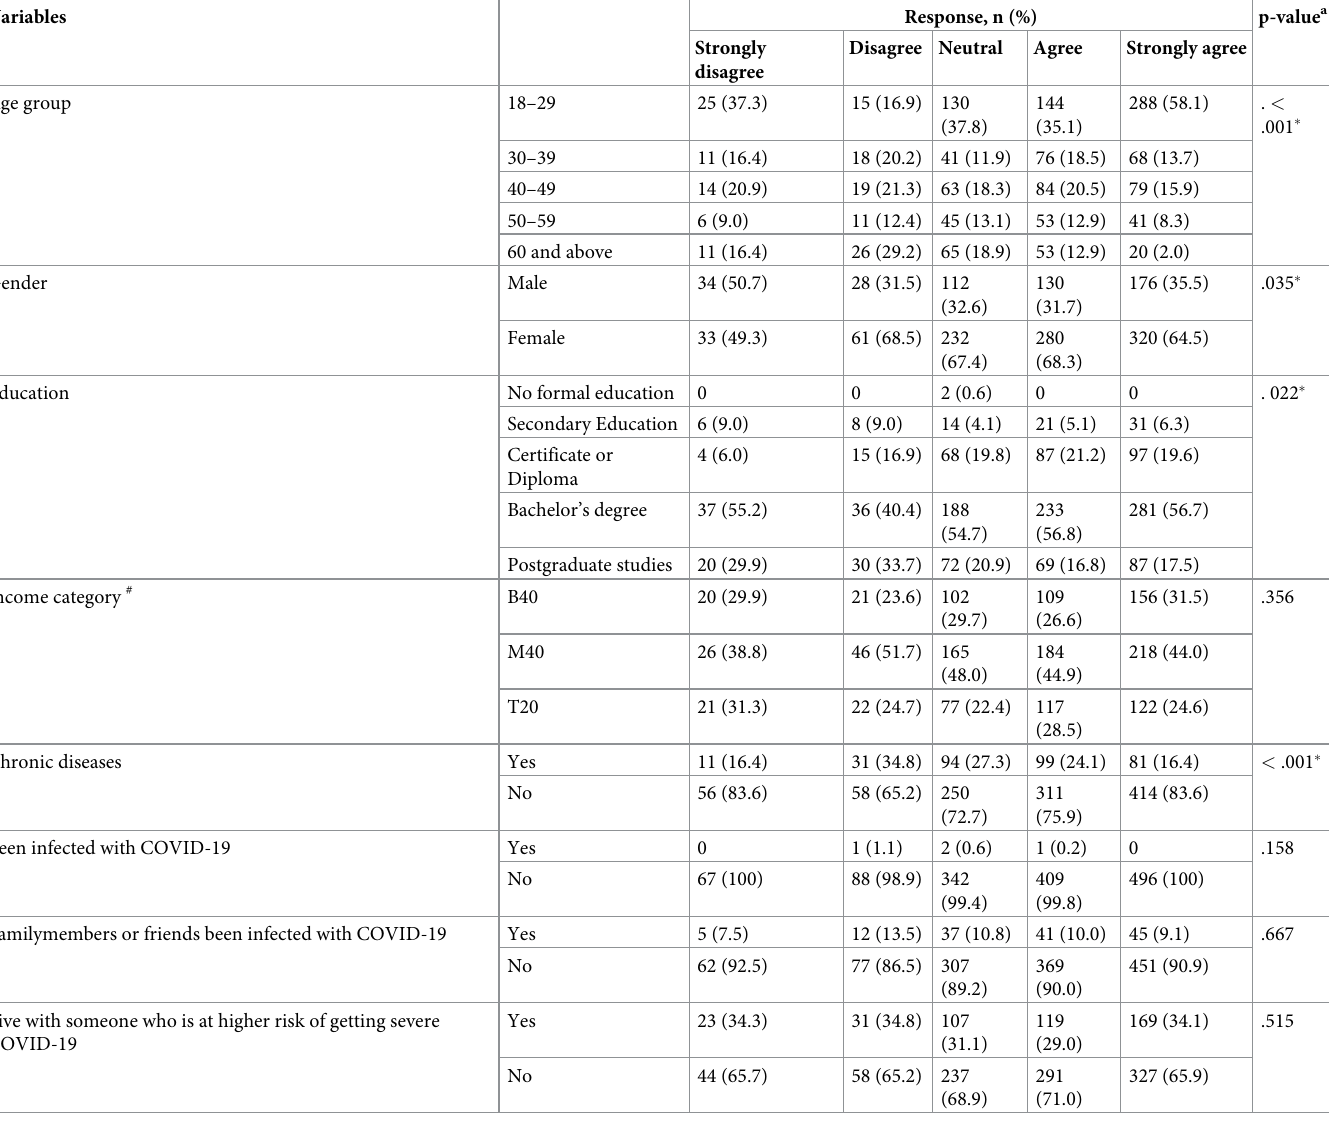
Table 5. Association between demographic factors and acceptance to COVID-19 vaccine (N =